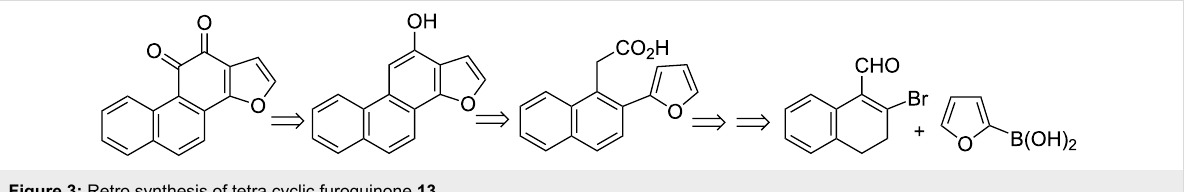
Figure 3: Retro synthesis of tetra cyclic furoquinone 13 .